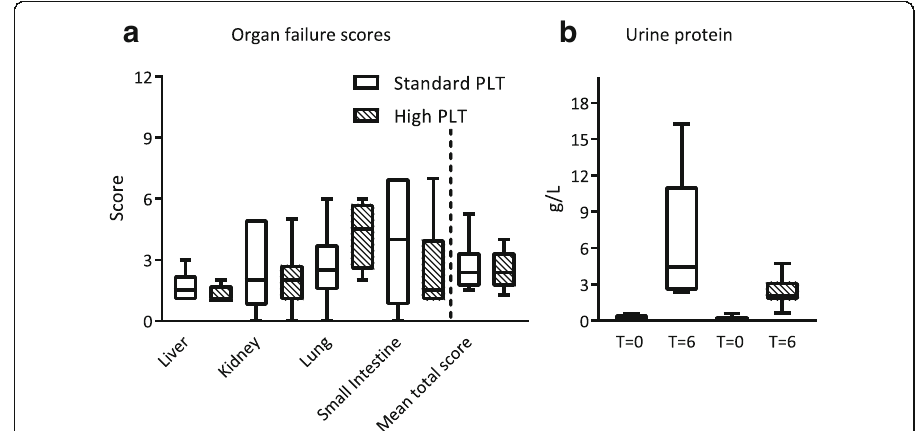
Fig. 3 Organ failure. Data are presented as median (IQR). PLT platelet transfusion. Due to mortality, histopathological analysis was done on 6/7 rats in standard PLT dose group and 8/8 in high PLT dose group. a Organ failure scores. b Urine